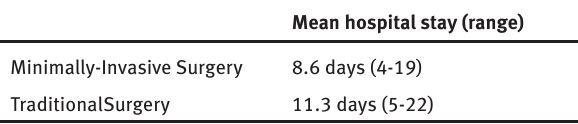
Table 2.4: Hospital